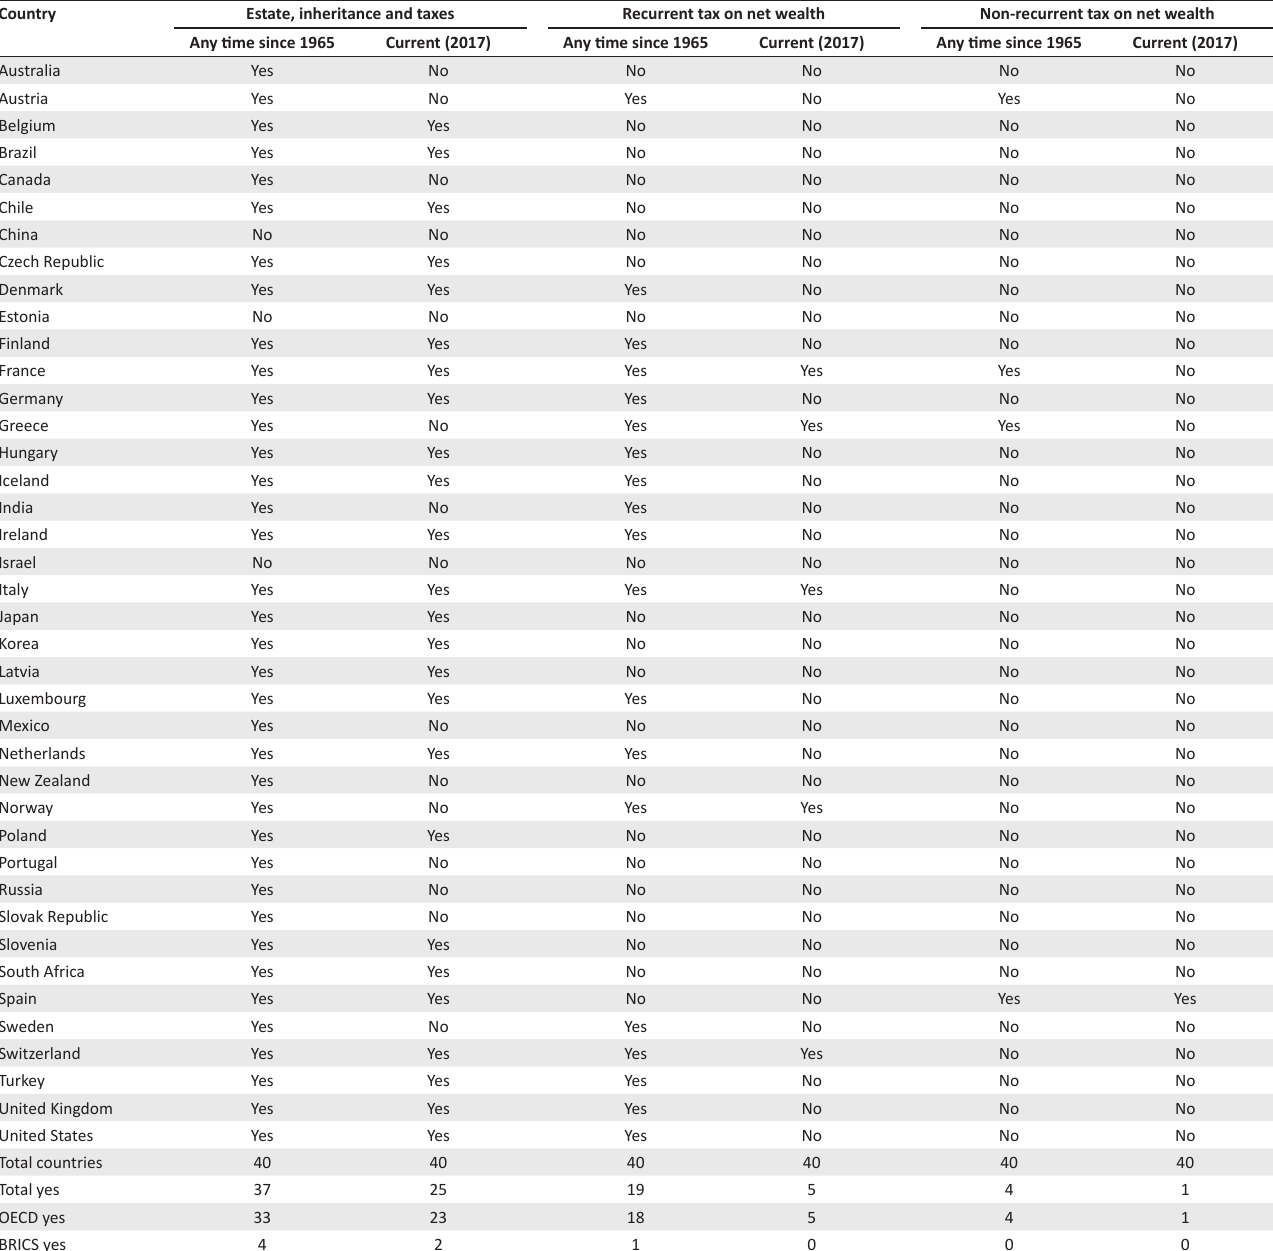
TABLE 1: Wealth tax in Organisation for Economic Co-operation and Development and BRICS countries.